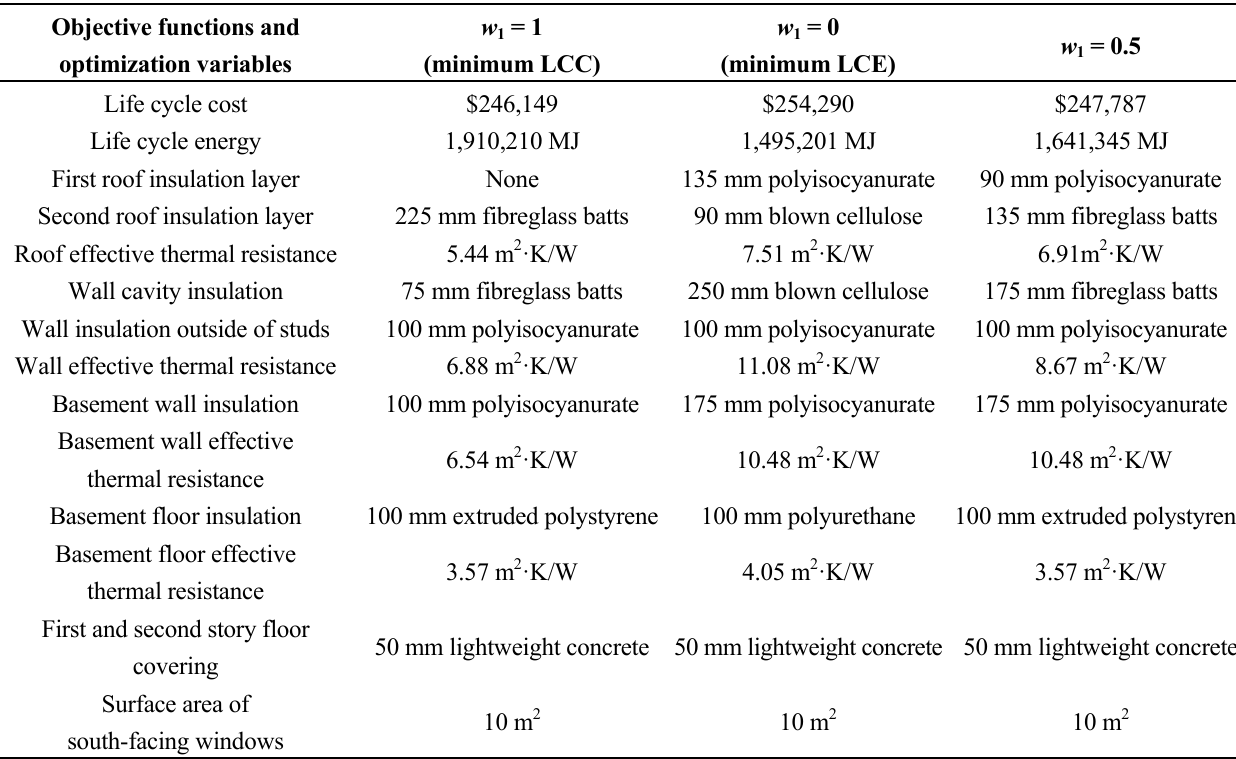
Table 5. Comparison of the minimum life cycle cost (LCC) and life cycle energy (LCE) design